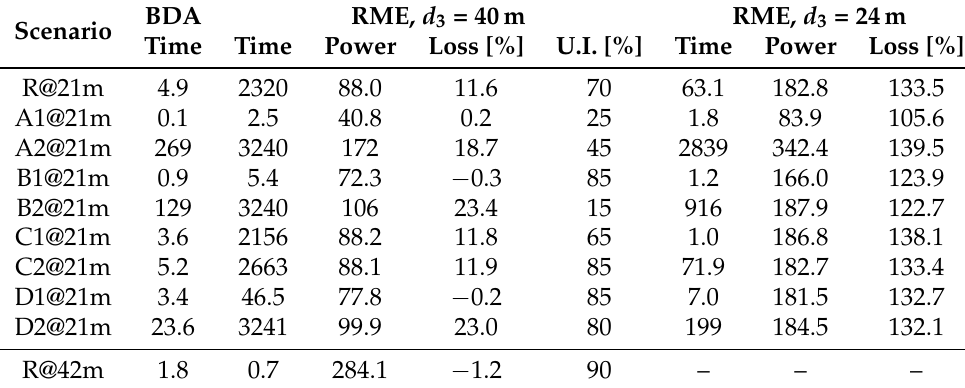
Table 7. Comparison between BDA and